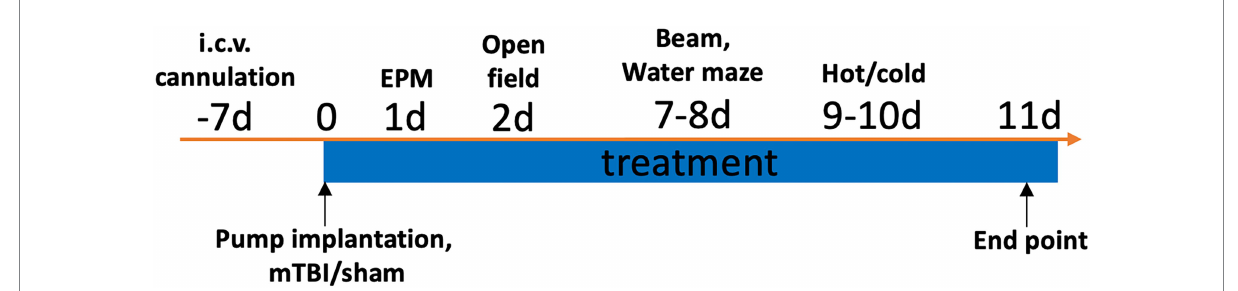
FIGURE 1 Study timeline. One week after the ICV cannulation, rats were implanted with an osmotic pump and immediately received either a LI induced mTBI or sham injury. Rats received the VEGF-A or VEH treatment throughout the study. Behavioral testing was conducted over the subsequent 10 days, and post-mortem analysis was conducted at 11 days after the injuries.